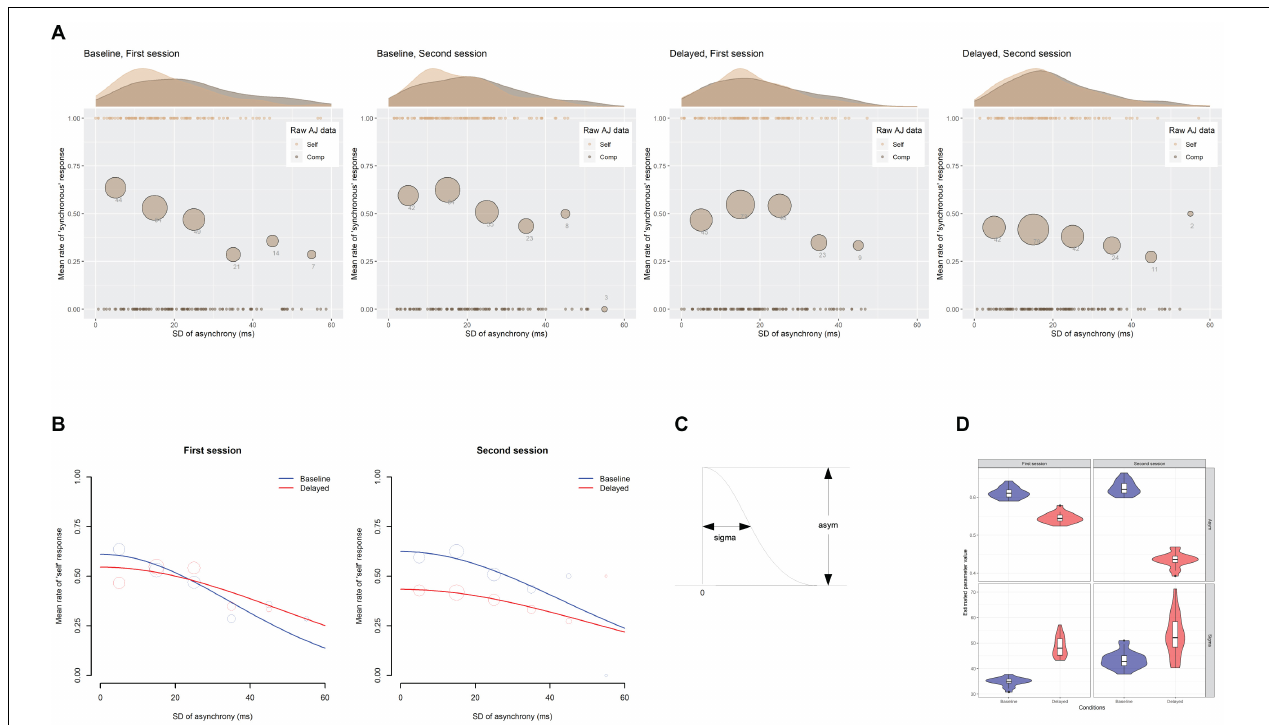
FIGURE 8 | Results from the analysis on a trial-by-trial basis about the agency judgment (AJ) data under the computer-controlled trials against the SD of asynchrony. (A) Scatter plots of the raw AJ data against the SD of asynchrony that is pooled across participants for each condition in two sessions. The probability density of the data is displayed as a curve outside the plot. The mean rate of the “self” responses against the six bins of the SD of asynchrony is displayed as a circle within the plot. The size of the circle reflects the number of observations in the bin, which is also indicated by the digit below the circle. (B) Fitted half-Gaussian functions of the AJ against the SD of asynchrony for each condition in two sessions. Mean rate of “self” response against the binned SD of asynchrony was also displayed for reference. The size of the circle reflects the number of observations. (C) The asym and sigma are the parameters of the half-Gaussian representing height and width. (D) Violin plots with boxplots representing the distribution of the estimated parameters from the 18 jackknife replications of the fitting of the half-Gaussian function to the AJ against the SD of